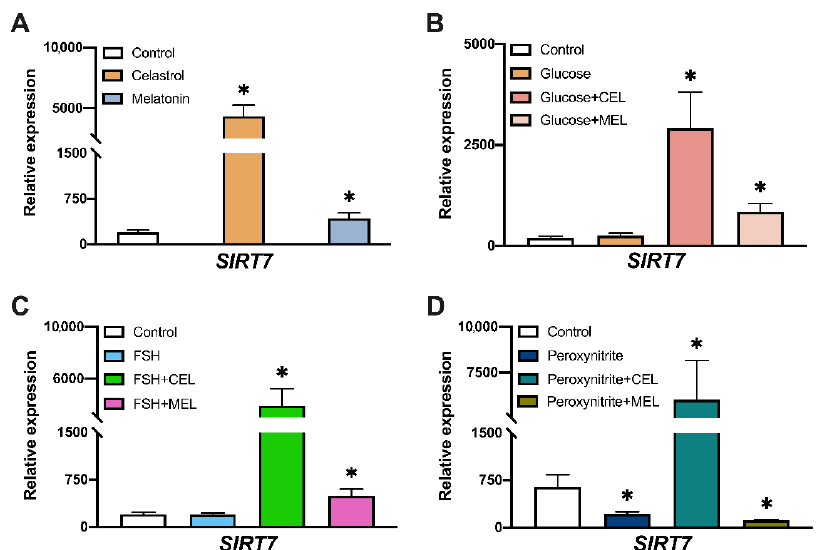
Figure 5. Effect of glucose, peroxynitrite, FSH, celastrol (CEL), melatonin (MEL) and their combinations on SIRT7 gene expression. SIRT7 relative expression levels in hGL cells treated with: ( A ) celastrol ( n = 19) or melatonin ( n = 18), ( B ) glucose ( n = 17) and in combination with celastrol ( n = 19) or melatonin ( n = 18), ( C ) FSH ( n = 17) and in combination with celastrol ( n = 19) or melatonin ( n = 18), ( D ) peroxynitrite ( n = 20) and in combination with celastrol ( n = 18) or melatonin ( n = 17). Asterisks (*) indicate statistically significant differences compared to control.